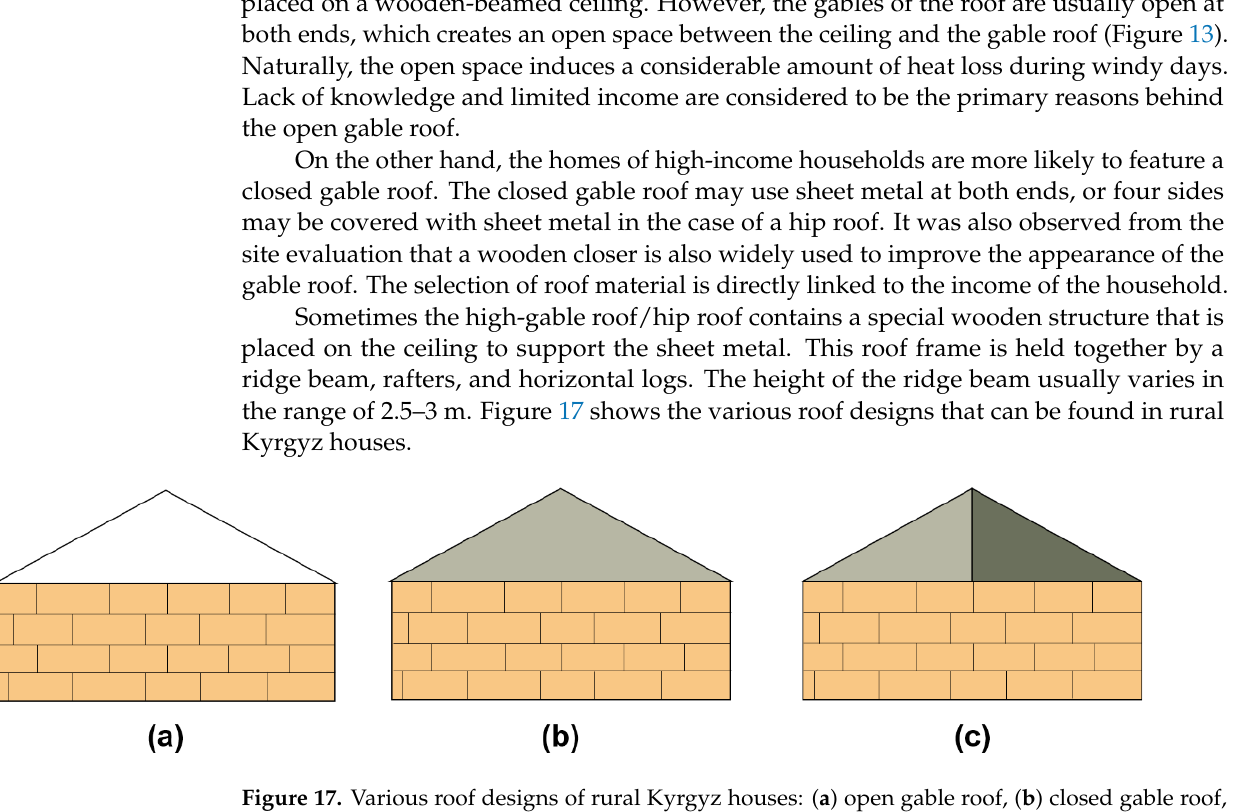
Figure 17. Various roof designs of rural Kyrgyz houses: ( a ) open gable roof, ( b ) closed gable roof, ( c ) hip roof. ( c ) hip